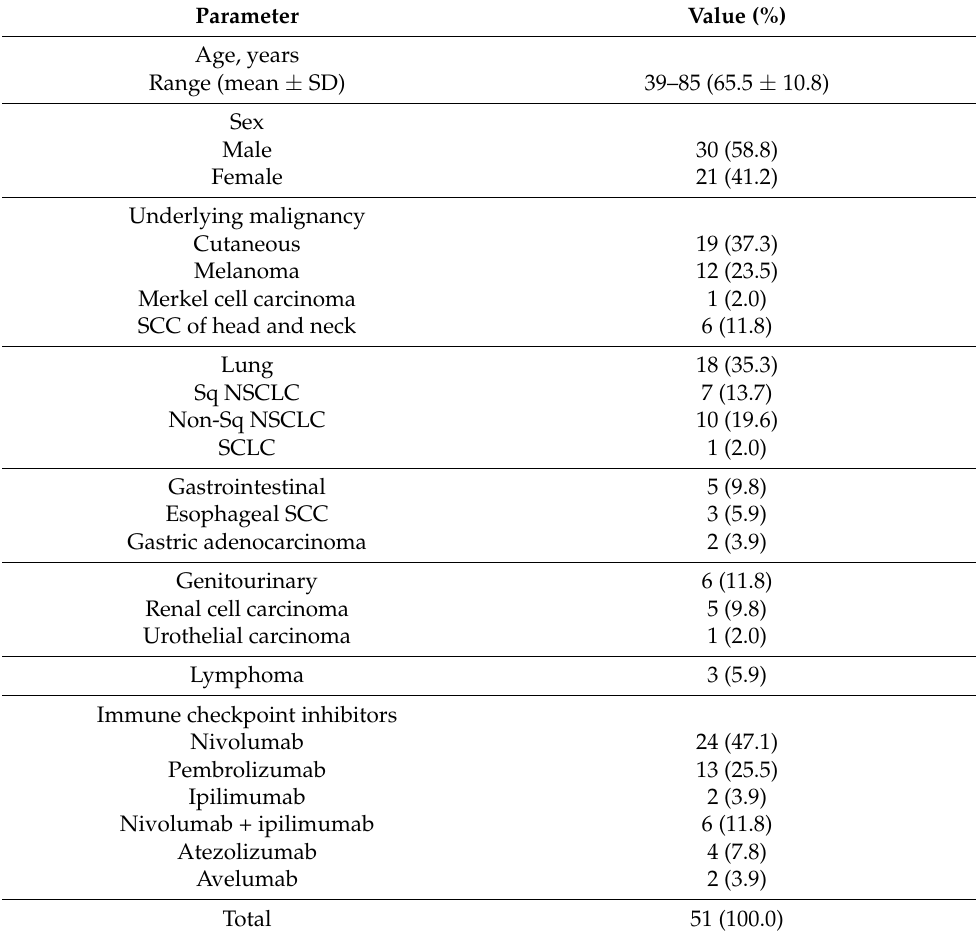
Table 1. Demographics, underlying malignancy, and immunotherapy of the trial